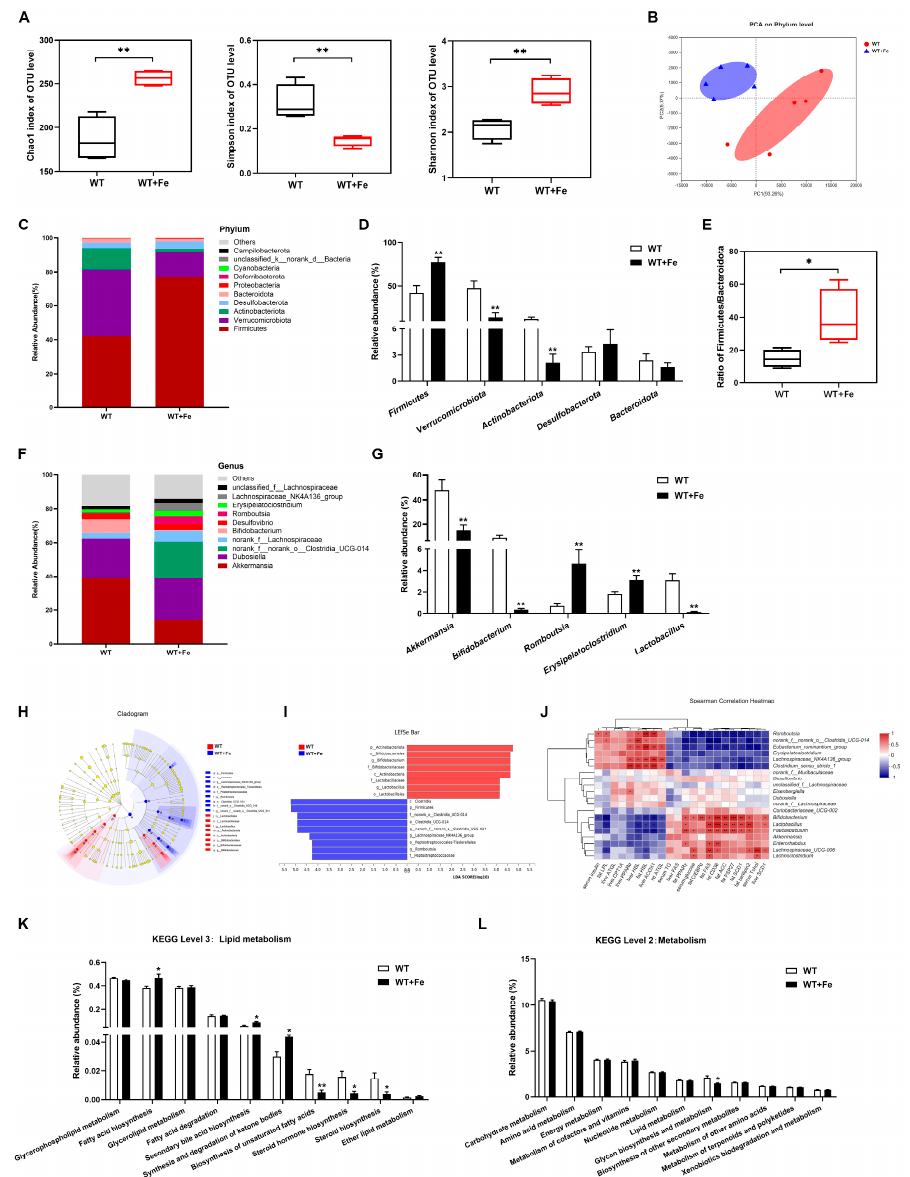
Figure 4. A high-iron diet reshaped the gut microbiota of mice. ( A ) Alpha diversity. ( B ) PCA plot. ( C ) Microbiota distribution at the phylum level. ( D ) Relative abundance of dominated phylum. ( E ) Ratio of Firmicutes/Bacteroidetes. ( F ) Microbiota distribution at the genus level. ( G ) Relative abundance of dominated genus. ( H ) Cladograms. ( I ) LEfSe analysis, LDA scores > 4.0. ( J ) Spearman correlation heatmap at the top 20 genus level. ( K ) Microbial metabolic function of KEGG pathways at level 3 lipid metabolism. ( L ) Microbial metabolic function of KEGG pathways at level 2 metabolism. Data are presented as the mean ± SEM. * p < 0.05, ** p <